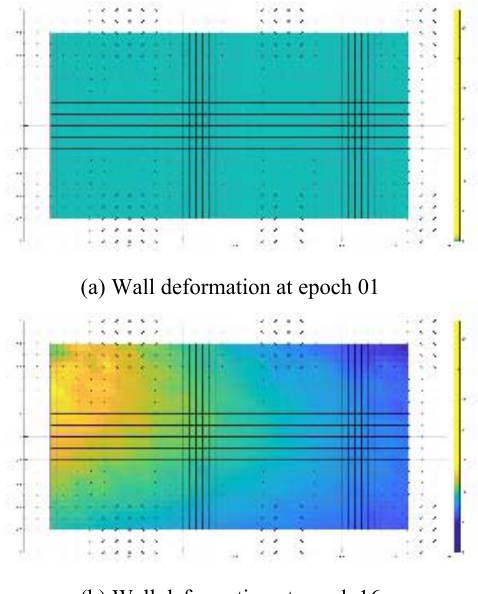
The other way to understand the behaviour of concrete wall during experiment is 2D profile analysis. The displacement of wall and also the deformation of wall can be analysed by 2D profile analysis. Figure 6 show an example of 2D vertical profile on the right side of concrete wall. The Y-axis is vertical direction while X-axis is the delta Z opposite wall surface. Each line represent the cross-section of wall in vertical direction in different epochs (i.e., epochs 1, 16 and 29). The distance between two vertices in vertical direction (i.e., Y-axis) is about 10cm. The 2D profile indicates the displacement and deformation of wall in different stages. When external force is continuously applied to the wall, the wall slanted towards force direction and also have deformation in the upper part.